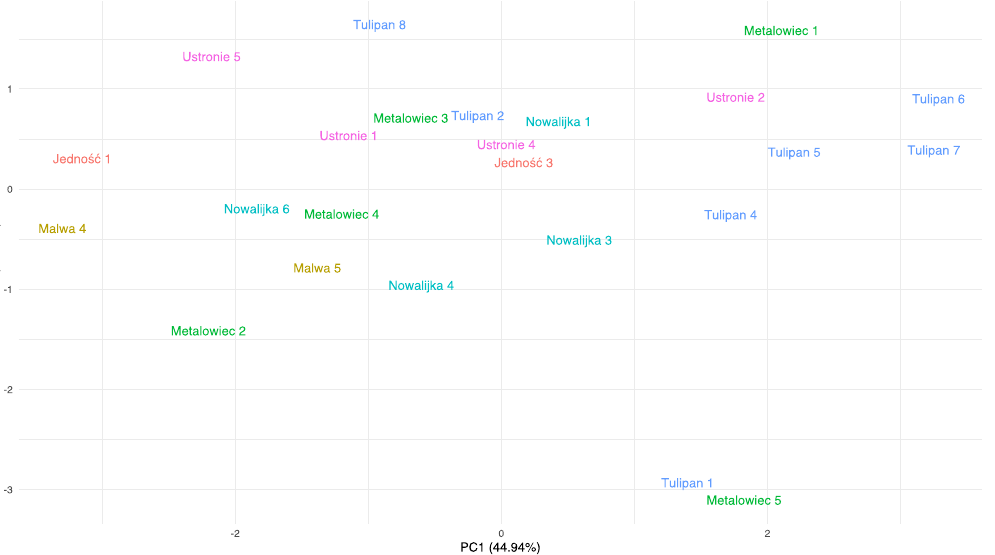
Figure 6. Dendrogram of 31 allotment plots calculated on the basis of root parameters.